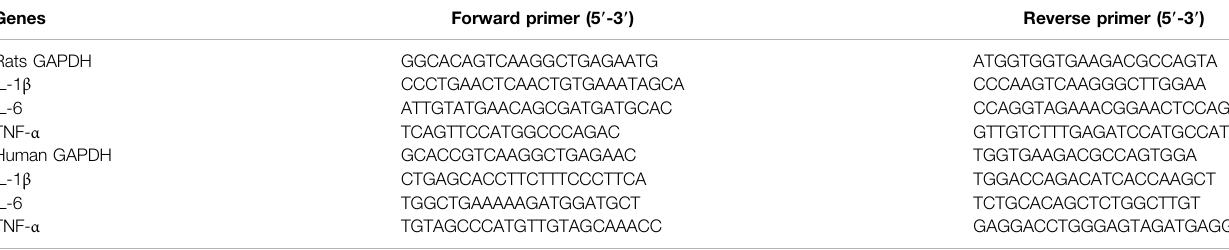
TABLE 1 | The primer sequences used for real-time PCR assay. Genes